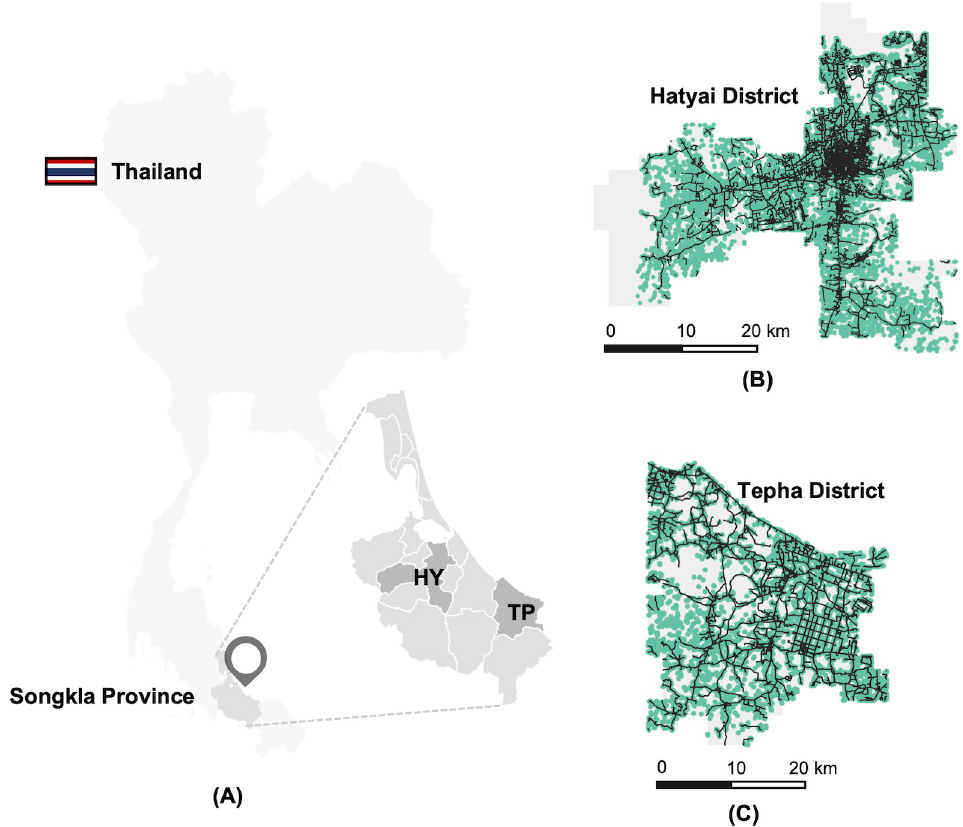
Fig 2. Study sites and geographical distribution of buildings and roads. (A) The locations of the study sites, Hatyai and Tepha district, in Thailand. (B and C) Spatial distribution of buildings (green patches) and roads (black lines) across Hatyai and Tepha district. The base layer of the map was obtained from https://data.humdata.org/dataset/thailand-